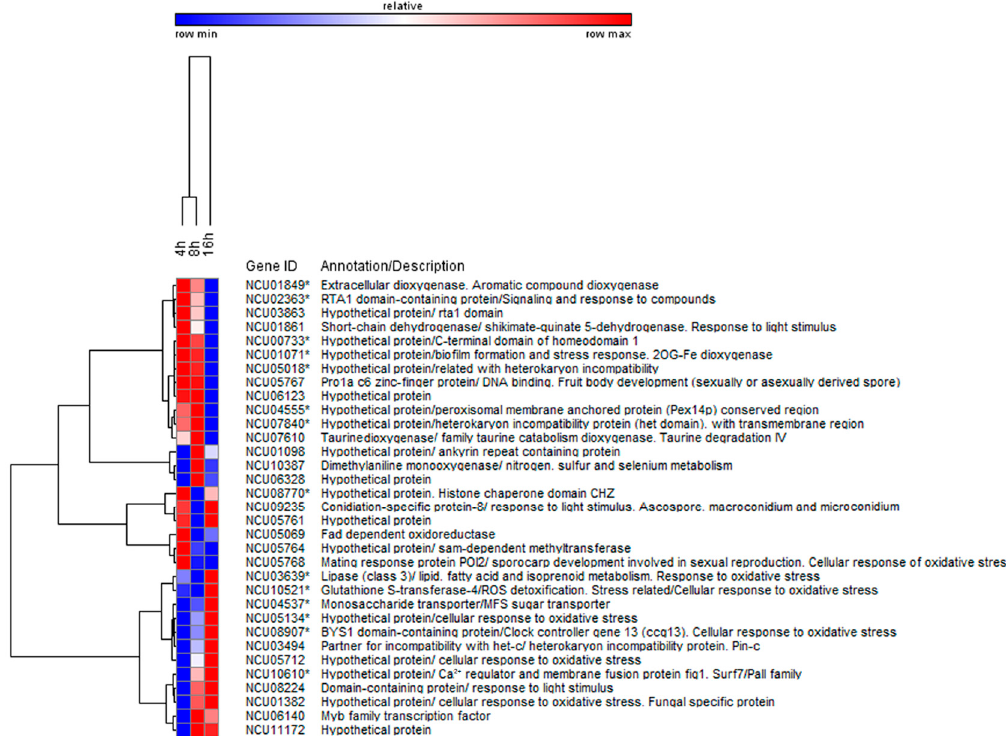
Figure 3. Hierarchical cluster analysis of a set of 33 genes involved in chitosan response to chitosan with an early and late induction in response to chitosan. Elaborated from Lopez-Moya et al. 2016 using data from GEO Series accession number GSE75293 [48]. This figure was created with the software GENE-E from Bioconductor repository